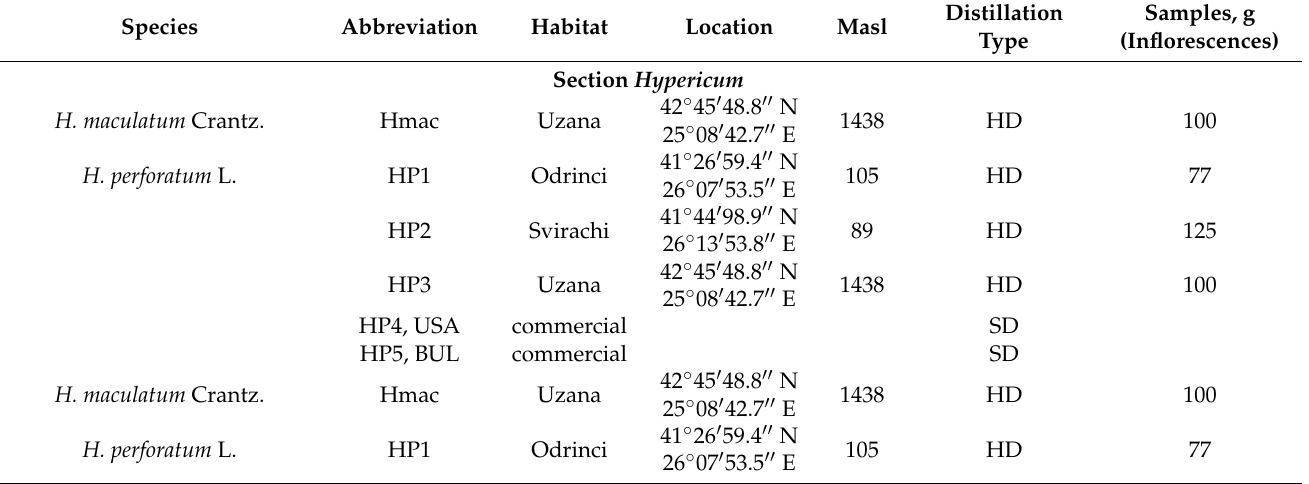
Table 9. Location coordinates, altitude (Masl), and sample size (g) of analyzed Hypericum species from